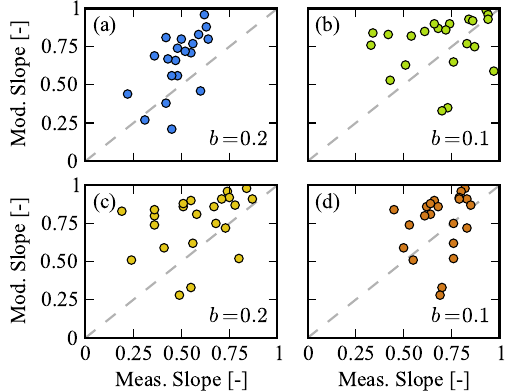
Figure 5. Comparison of modelled against measured slopes of the regression line between stream and air temperatures. The panels correspond to the different seasons: (a) January–March, (b) April– June, (c) July–September, and (d) October–December. The bias b corresponds to the average, in each season, of the difference be- tween the modelled and measured regression slopes over all the se- lected stations and years (i.e. belonging to both the calibration set and validation set 4). The 1:1 line is indicated as a dashed grey